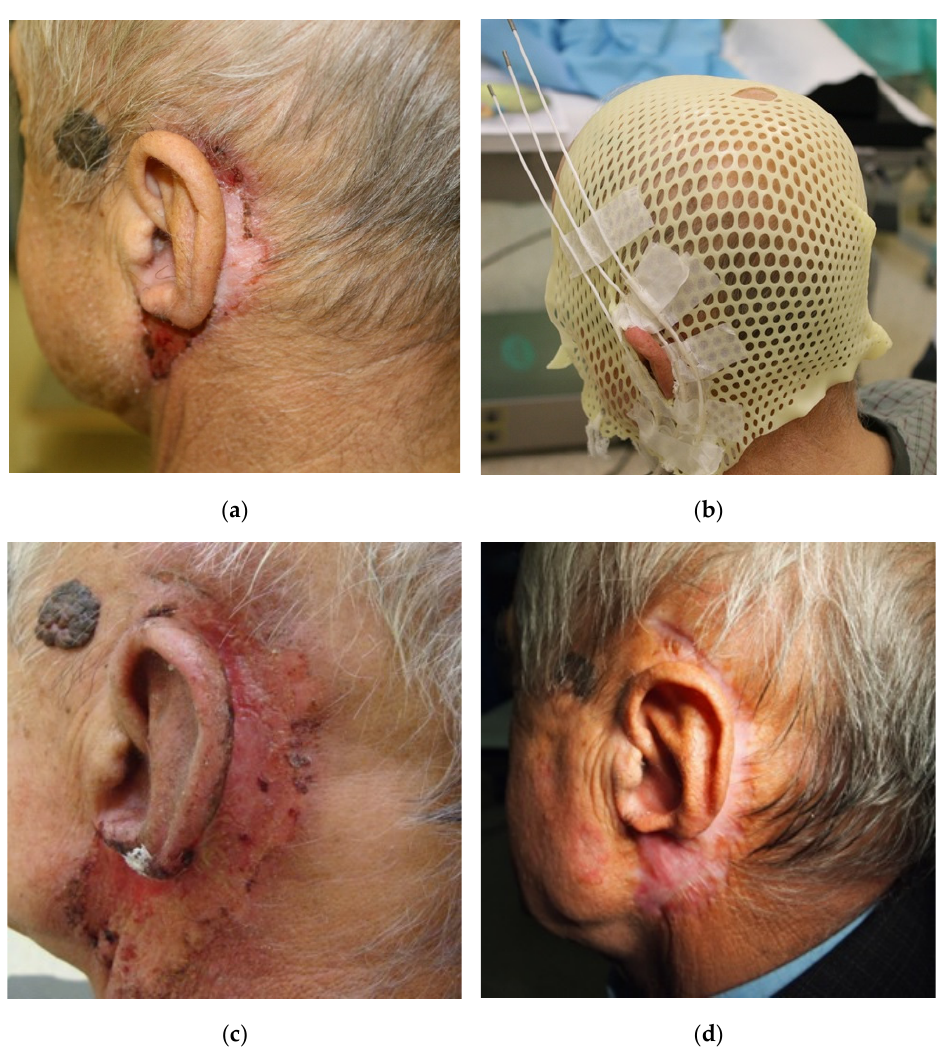
Figure 3. Sample photos of one of the treated patients (the same patient whose plan is presented in Figure 2). ( a ) the image of the primary lesion before the start of treatment; ( b ) the patient with a thermoplastic mask and sewn/glued applicators in the area of the neoplastic lesion; ( c ) the image of an acute radiation reaction, four weeks after the end of brachytherapy; ( d ) the effect obtained six months after the end of